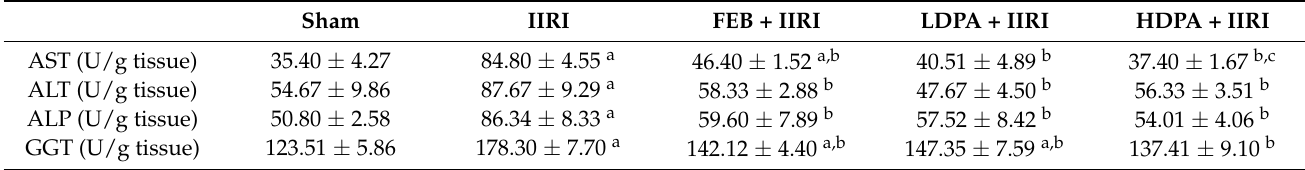
Table 3. Effect of intestinal ischemia/reperfusion (I/R) and methanolic Phyllanthus amarus leaf extract on hepatic injury markers.